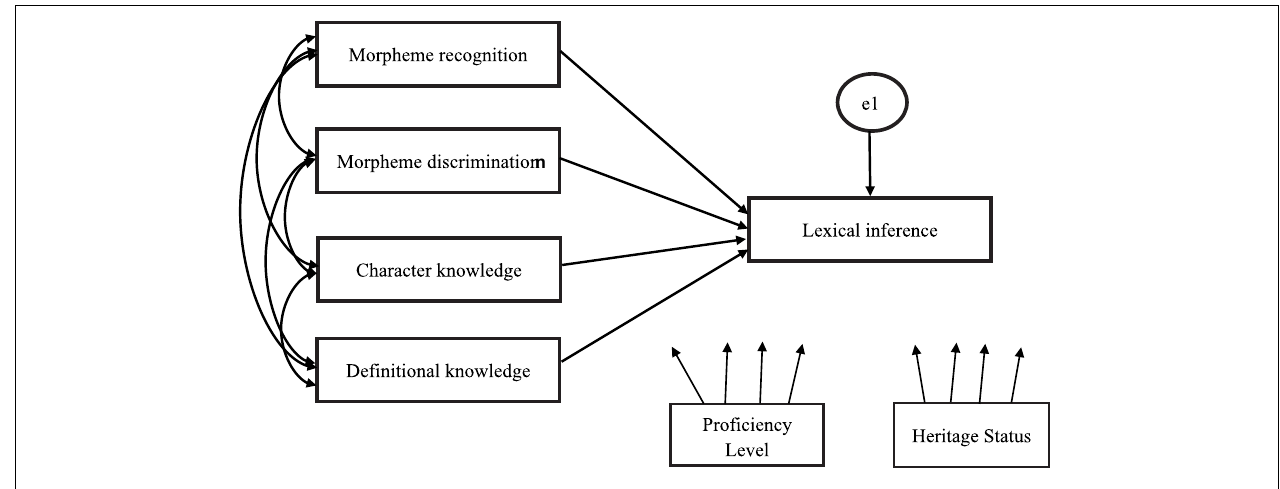
FIGURE 1 | Hypothesized path model.